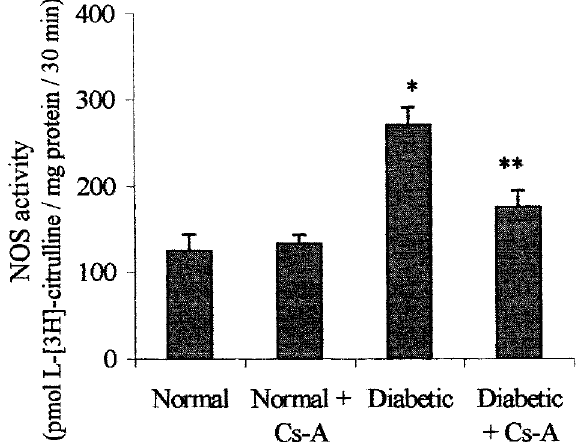
FIG. 2. Measurements of NOS activity in retina. Retinal lysates (0.5mg protein/ml) were incubated in a medium containing 1 mM EGTA, 0.5 mM NADPH and 10nM L- [ 3 H]-arginine in the presence or absence of 2 mM Ca 2+ , in a total volume of 200 m